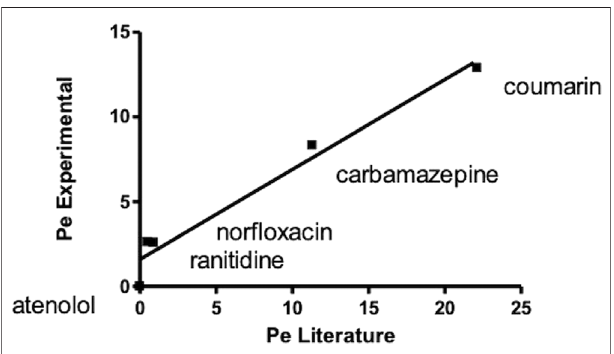
FIGURE 4 | Correlation graph for experimental and theoretical Pe of standard compounds obtained carrying out a PAMPA test for oral absorption